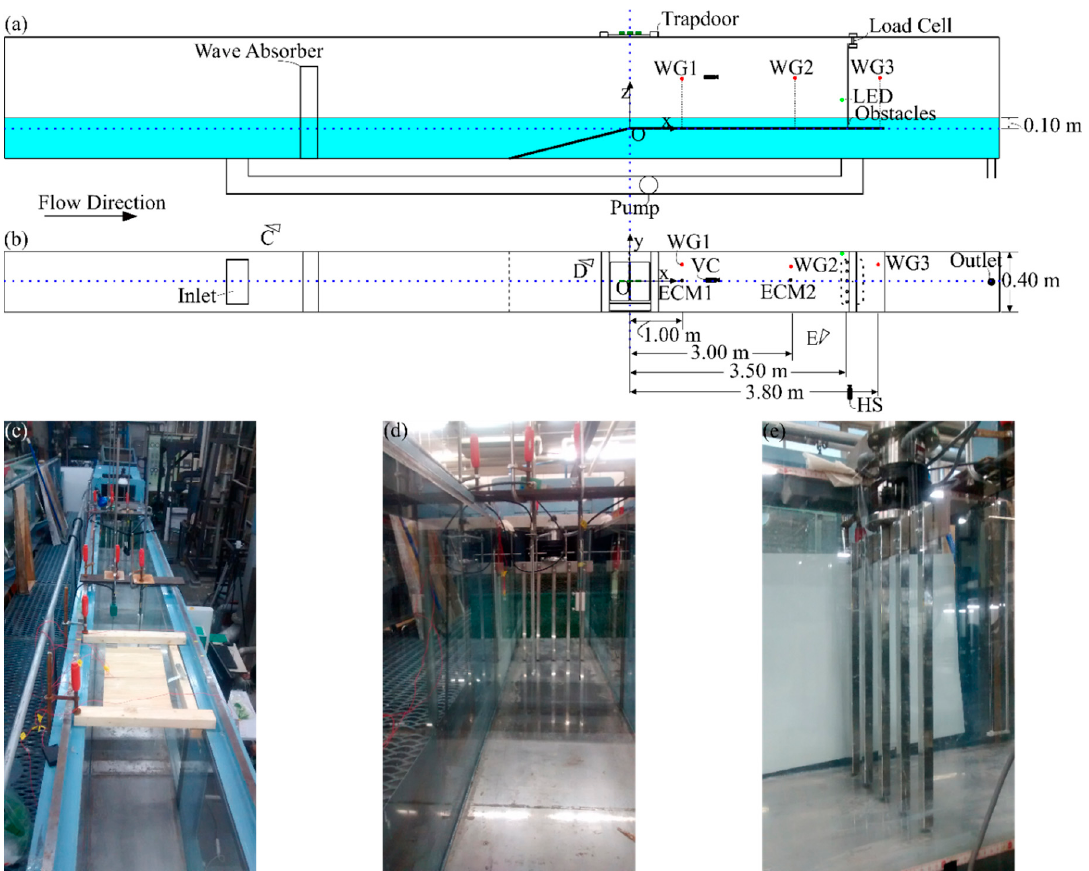
Figure 1. High-discharge flume at Waseda University: ( a ) side view of the flume; ( b ) top view; and the view of the three subsequent images ( c – e ). The WG are shown as red circles, the ECM are shown as black dots. The coordinate system is indicated as a blue dotted line in ( a , b ).